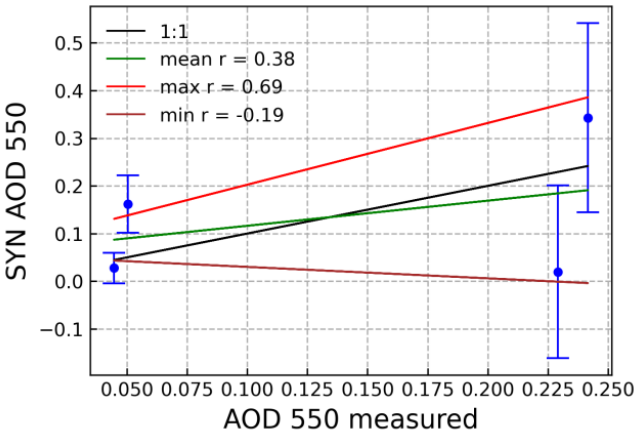
Figure 4. AOD scattering diagram at a reference wavelength of 550 nm according to SYN_AOD and measurement data: black line denotes the line of equal values; green, red, and brown lines denote linear regressions on the average, maximum, and minimum values of SY_AOD; r in the legend is the Pearson coefficient; blue circles and vertical lines are SY_AOD and their uncertainties, respectively.